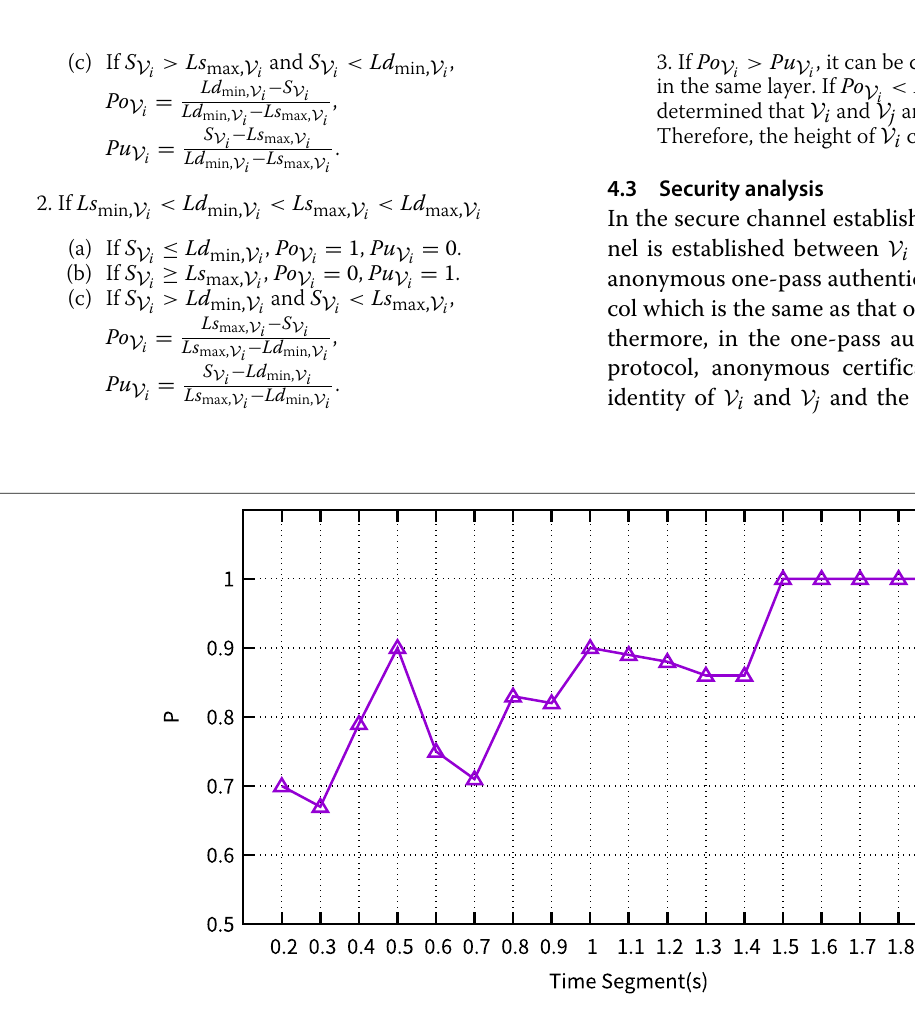
Fig. 6 Correct rate when two vehicles are traveling